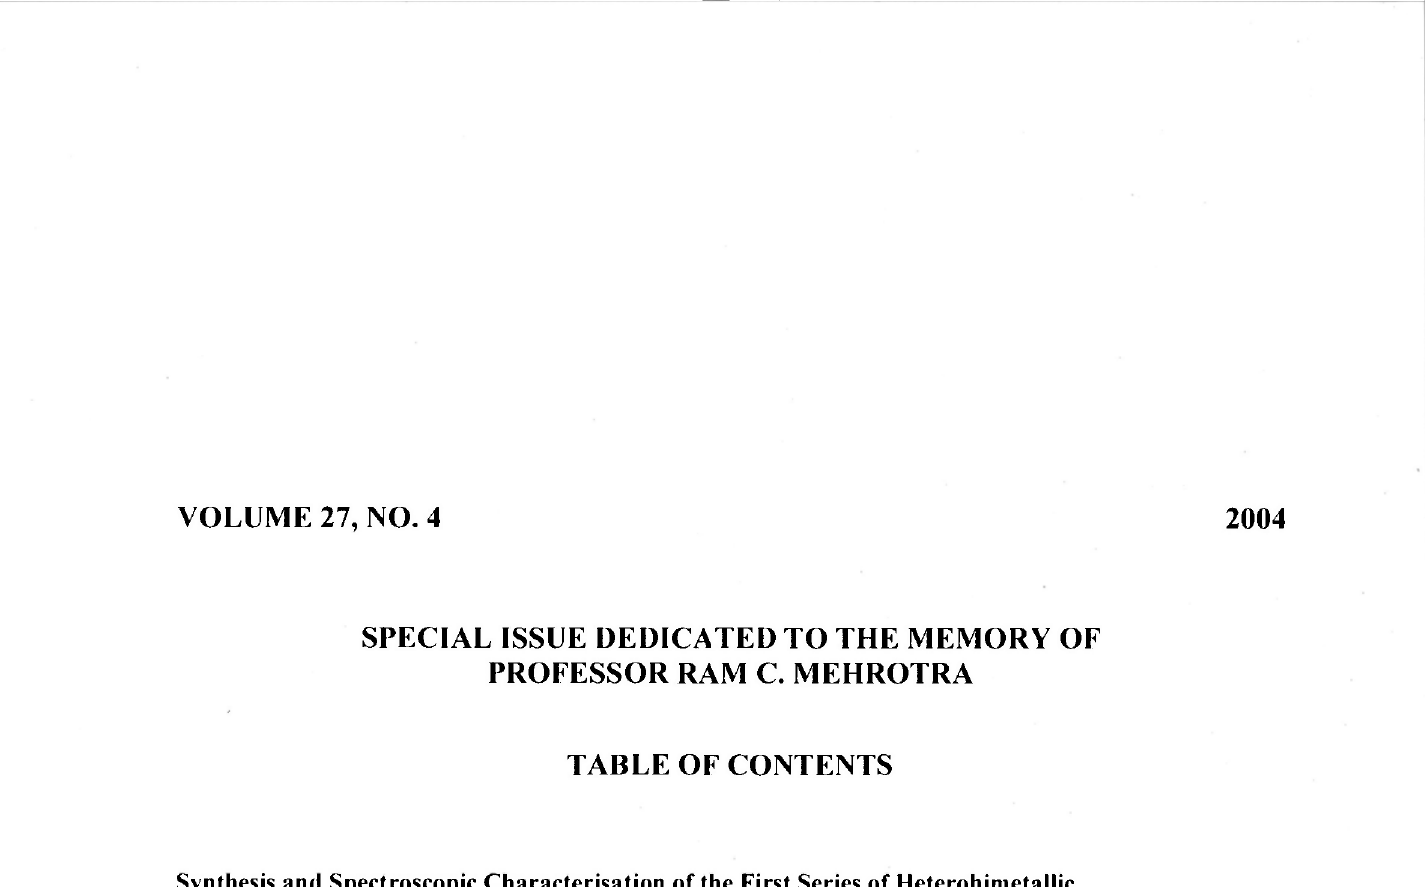
Synthesis and Spectroscopic Characterisation of the First Series of Heterohimetallic Butyltin(IV) Derivatives Based on Λ'—(1-hydroxyethyl) Salicylaldiminate Moieties Nandu Bala Sharma. Anirudh Singh and Ram C. Mehrotra